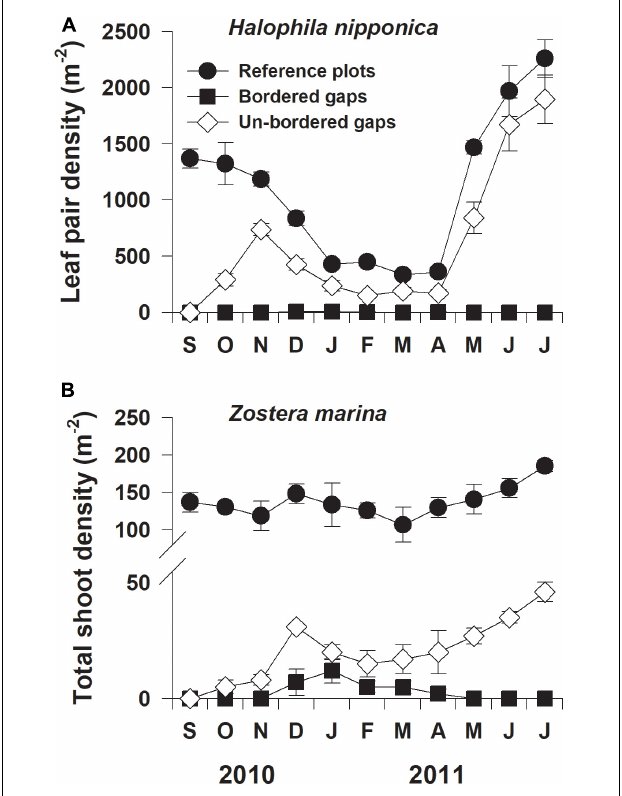
FIGURE 2 | Shoot densities of Halophila nipponica (A) and Zostera marina (B) at the reference plots and the bordered and un-bordered gaps at the study site from September 2010 to July